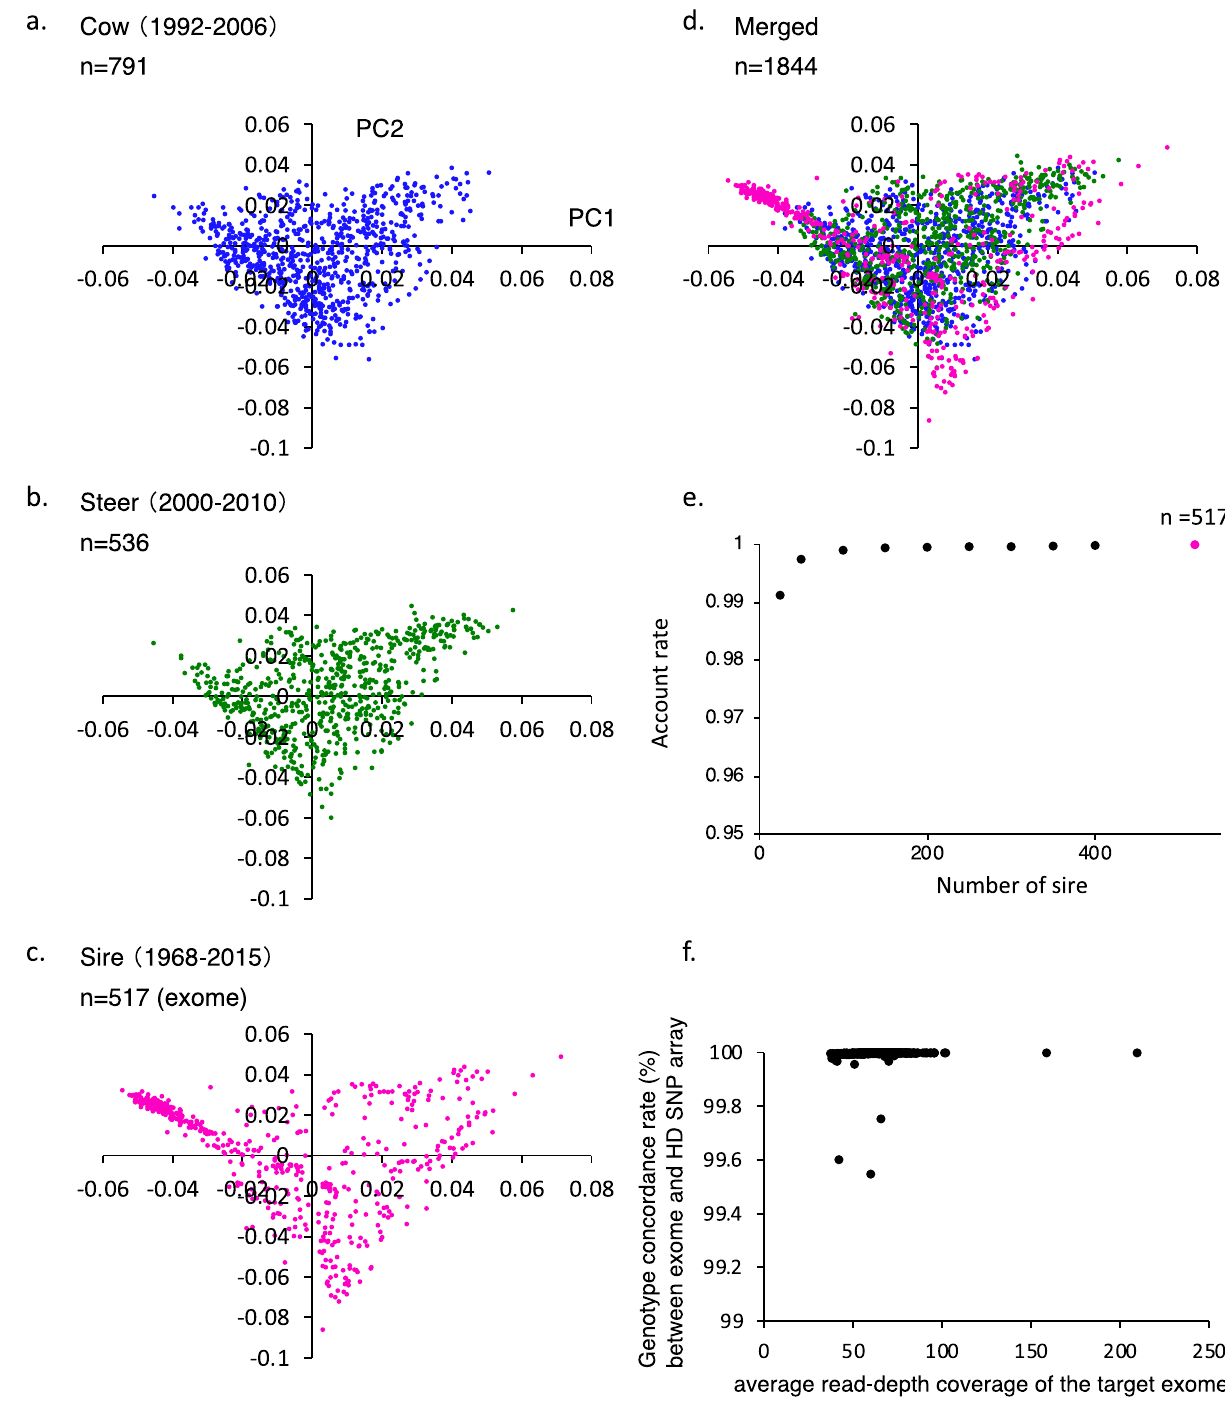
Figure 2. Genetic features and quality of whole exome sequences of 517 Japanese Black sires. ( a – d ) Principal component analysis of 1844 Japanese Black cattle, including 791 cows, 536 steers, and 517 sires, was performed using 593,358 autosomal SNPs. The individuals were plotted in a two-dimensional graph, with the first (x-axis: PC1) and the second (y-axis: PC2) principal components. ( d ) Data for 791 cows, 536 steers, 517 exome- sequenced sires were merged. ( e ) Account rate of haplotypes in 25 to 517 sires with the general Japanese Black cattle population. Two consecutive BovineHD SNPs in haplotypes of 517 exome-sequenced sires resulted in an account rate of near 100% with the general Japanese Black cattle population (red plot). The X-axis represents the number of sires, and the Y-axis represents the account rate. ( f ) Quality of exome sequence data of 517 sires. The genotype concordance rate between the exome-derived genotypes and the Bovine High-Density (HD) BeadChip array-derived genotypes was calculated based on 44,772 autosomal SNVs and plotted. The relationships are presented in a two-dimensional graph, with the average read-depth coverage of the target exome (X-axis) and the genotype concordance rate (%)